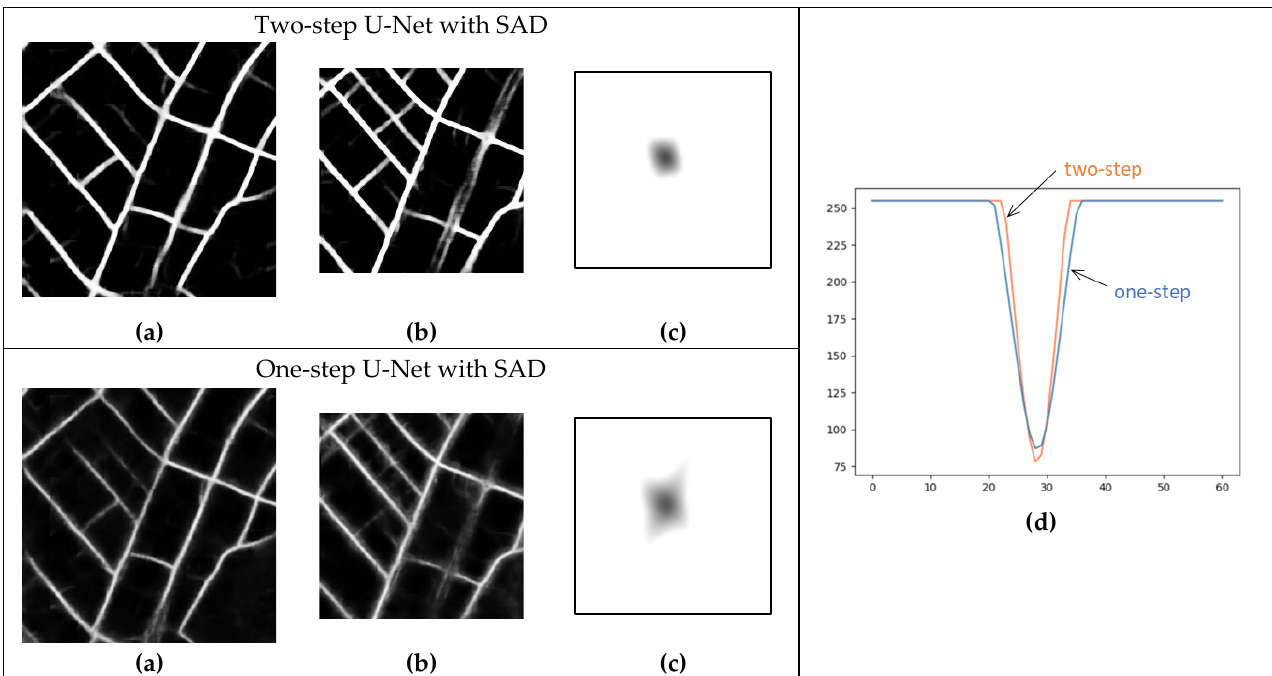
Figure 19. Comparison of template matching similarity map and curve between two-step and one- step U-Net with SAD (nos. 1 and 2, respectively in Table 5) using road mask image from WV-3 image as the reference and that from old-period aerial photo 1 as the target: (a) reference image, (b) target image and (c) similarity map and (d) similarity curve.